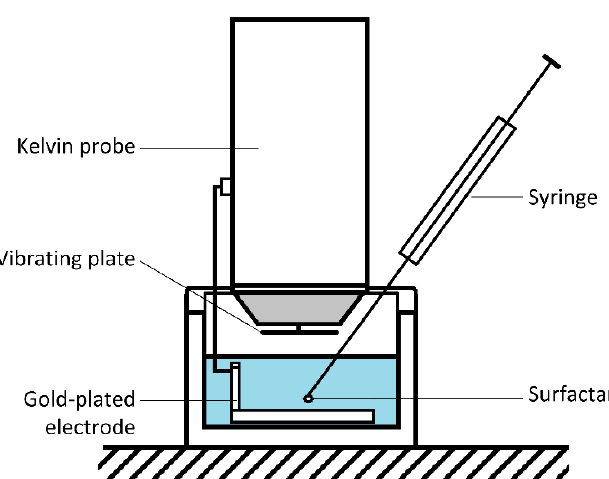
Figure 2. Scheme of the time-resolved surface potential experiment.